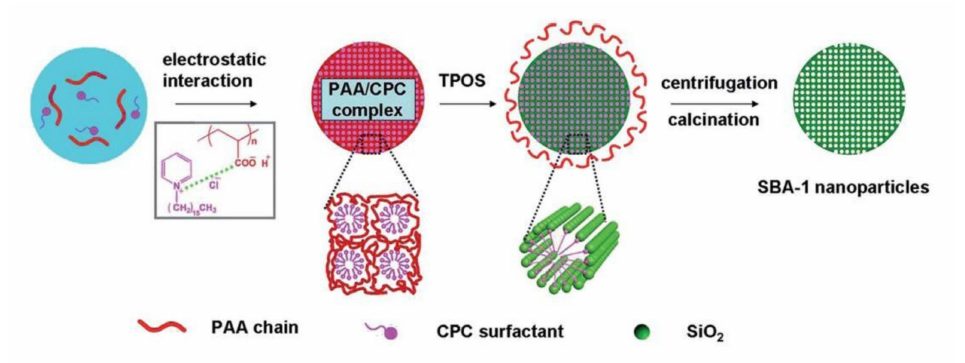
Figure 7. Schematic presentation of the procedure for obtaining SBA-1 nanoparticles using PAA / CPC complex as a template. Reprinted from Reference [75] with permission from The Royal Society of